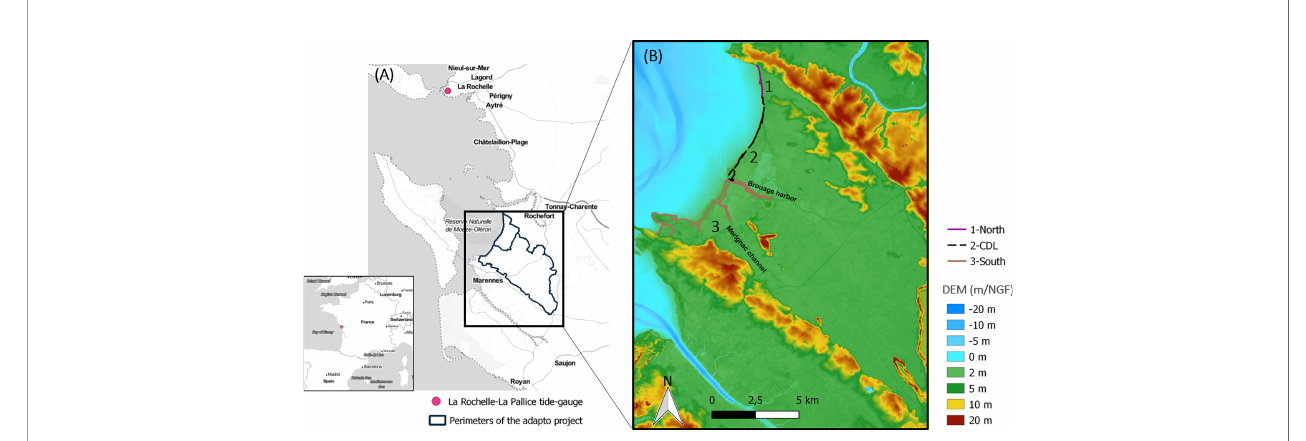
FIGURE 1 | 2 (A) Study site location. The black perimeter represents the immediate study area and the extended study area in the Adapto project; (B) Topo- bathymetric data used with a 20 m × 20 m resolution. The coastal defenses are represented in purple (1), black (2), and